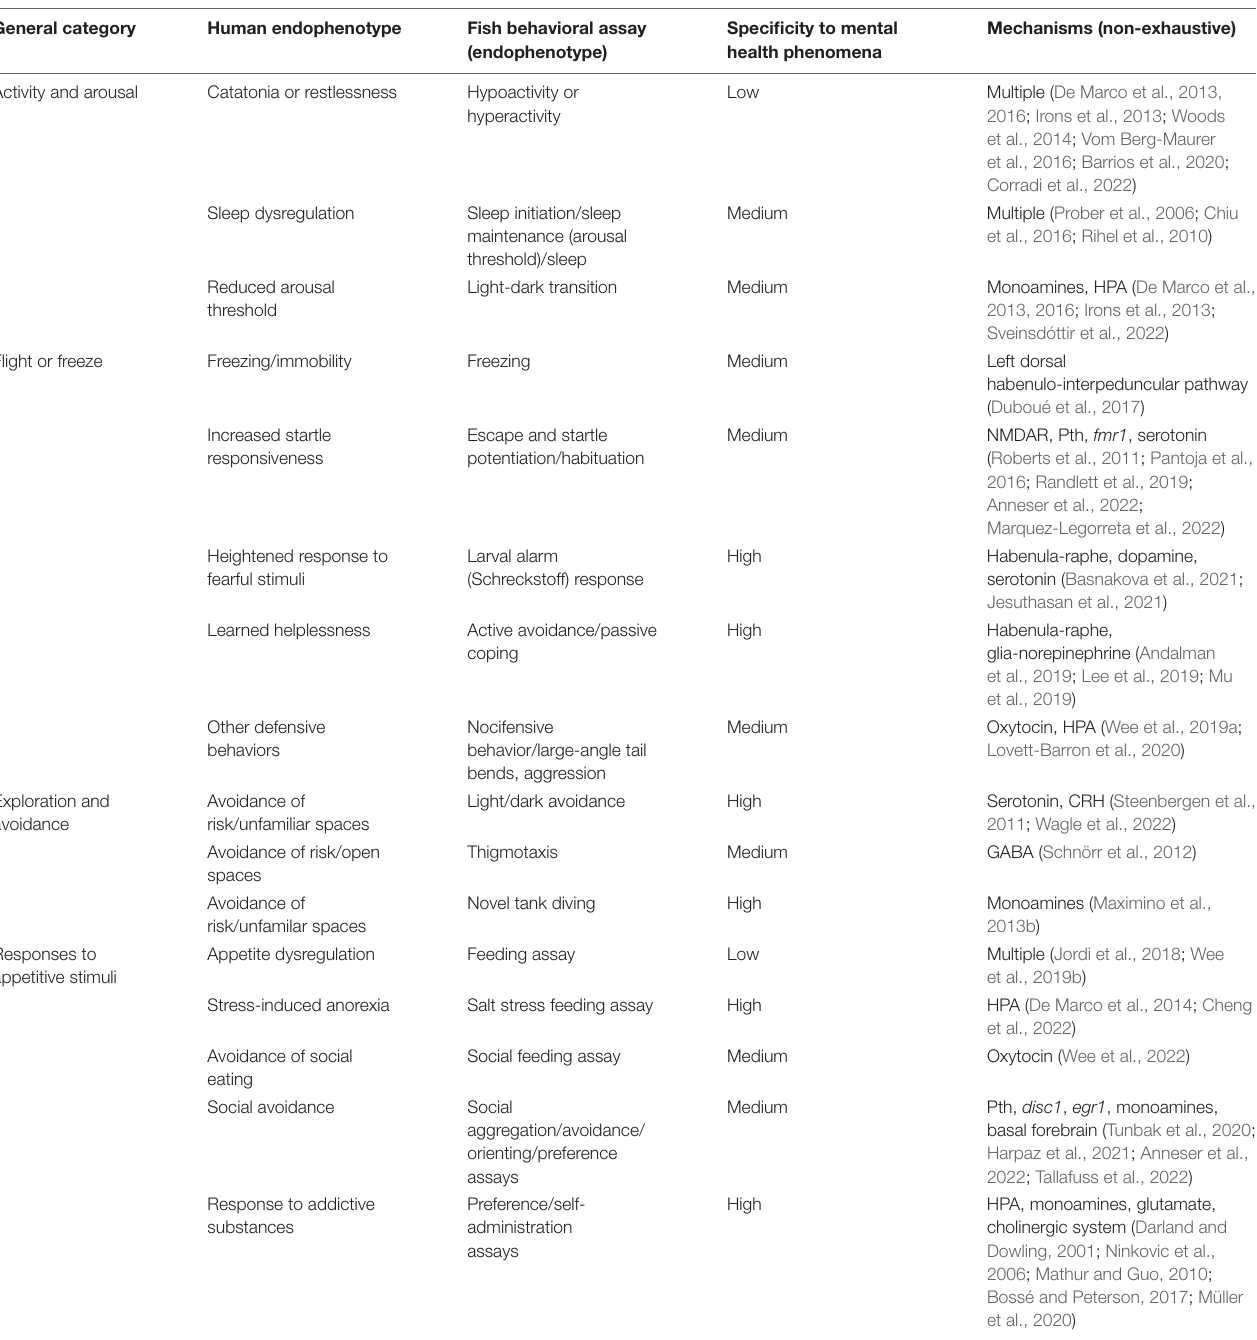
TABLE 2 | Summary of